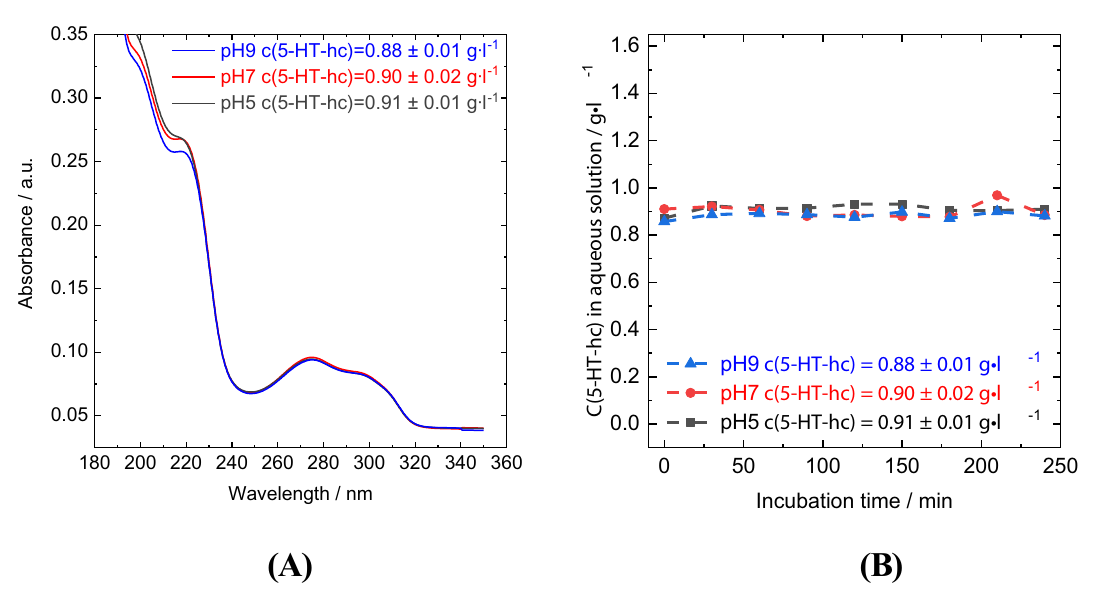
Figure 2. UV–Vis-spectra of 5-HT-hc at different pH values ( A ) and 5-HT-hc concentration over an incubation time of 4 h in the absence of a zeolite adsorbent ( B